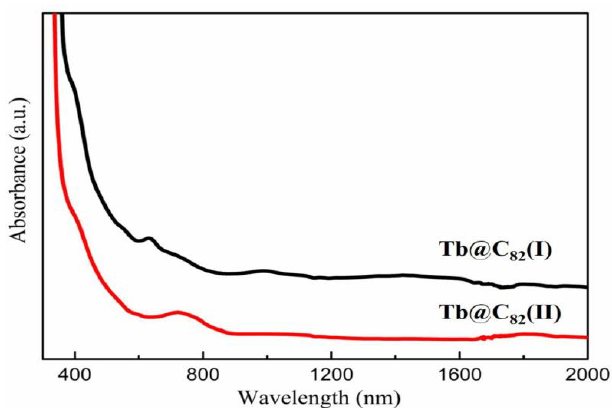
Figure 3. The vis-NIR absorption spectra of Tb@C 82 (I, II) isomers in CS 2 at 298 K.